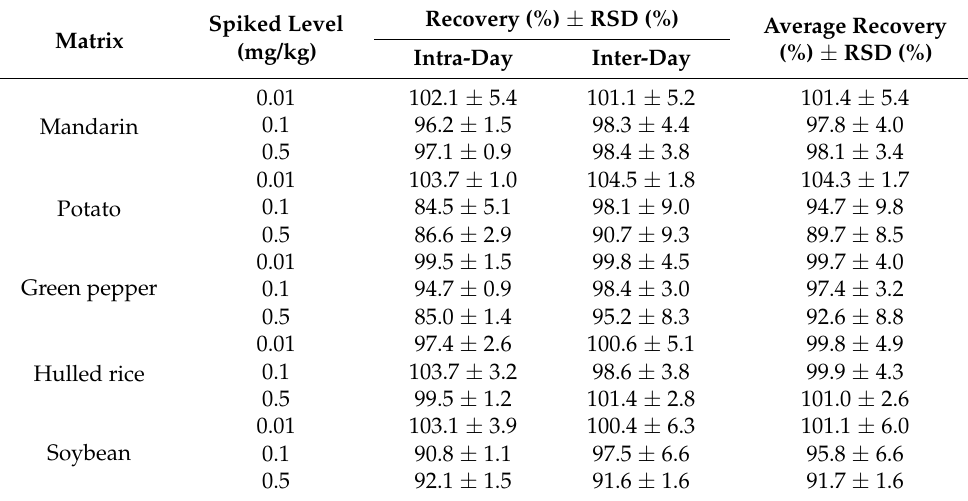
Table 3. Validation results of the analytical method for triflumezopyrim at three spiked levels from representative agricultural